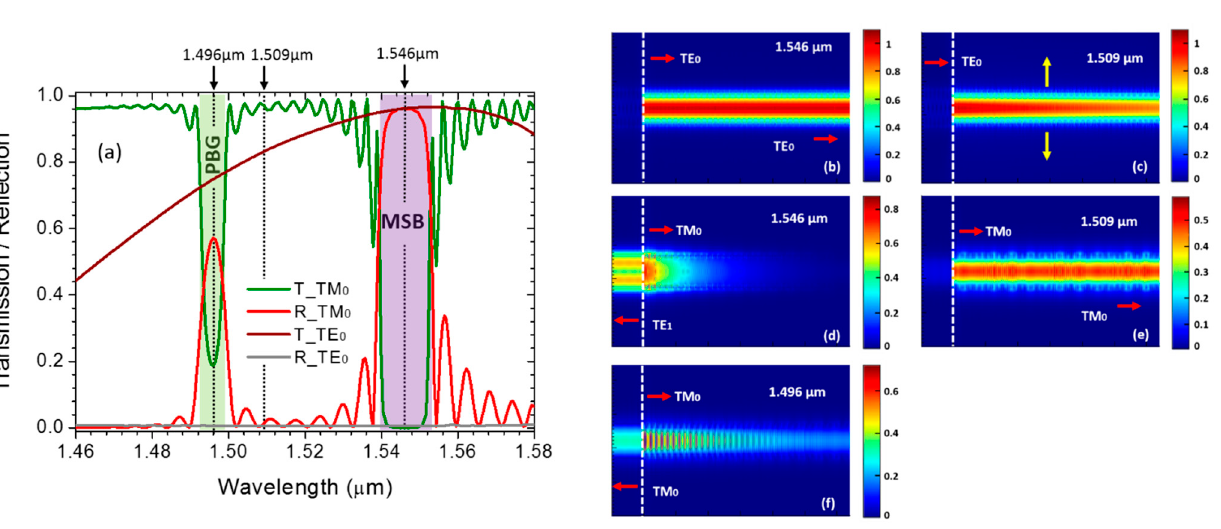
Figure 3. ( a ) Transmission and reflection spectra of uniform MWG. The light propagation profiles (electric field intensity |E| ) in uniform MWG section when TE 0 mode and TM 0 mode are injected, at wavelengths of ( b , d ) 1.546 μ m, ( c , e ) 1.509 µ m, and ( f ) 1.496 μ m.